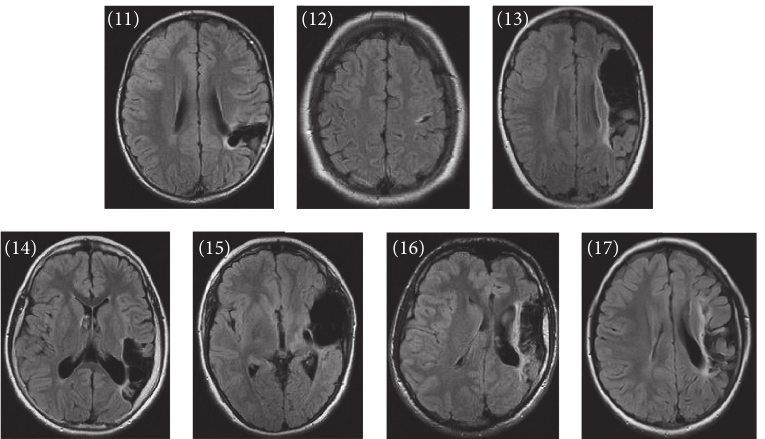
Figure 2: Anatomical fluid attenuated inversion recovery sequence images for each of the patients with arterial ischemic stroke according to patient number in Table 1. The single axial slices display maximum lesion volume. The individual injury patterns are detailed in Table